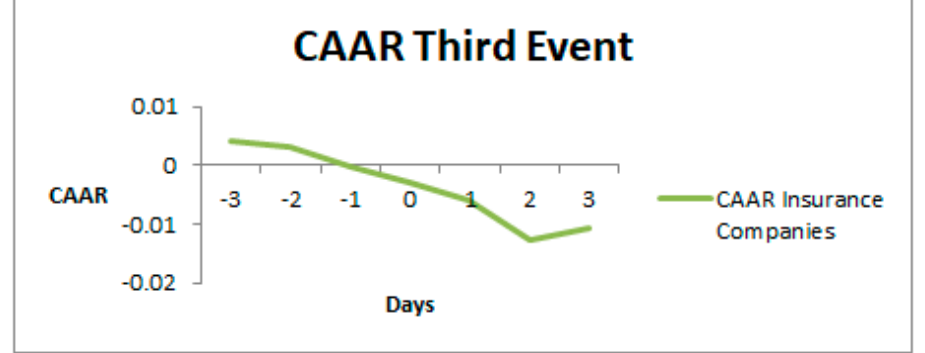
Figure A5. C AARs for insurance companies associated with the second event. Source: Authors’ work.